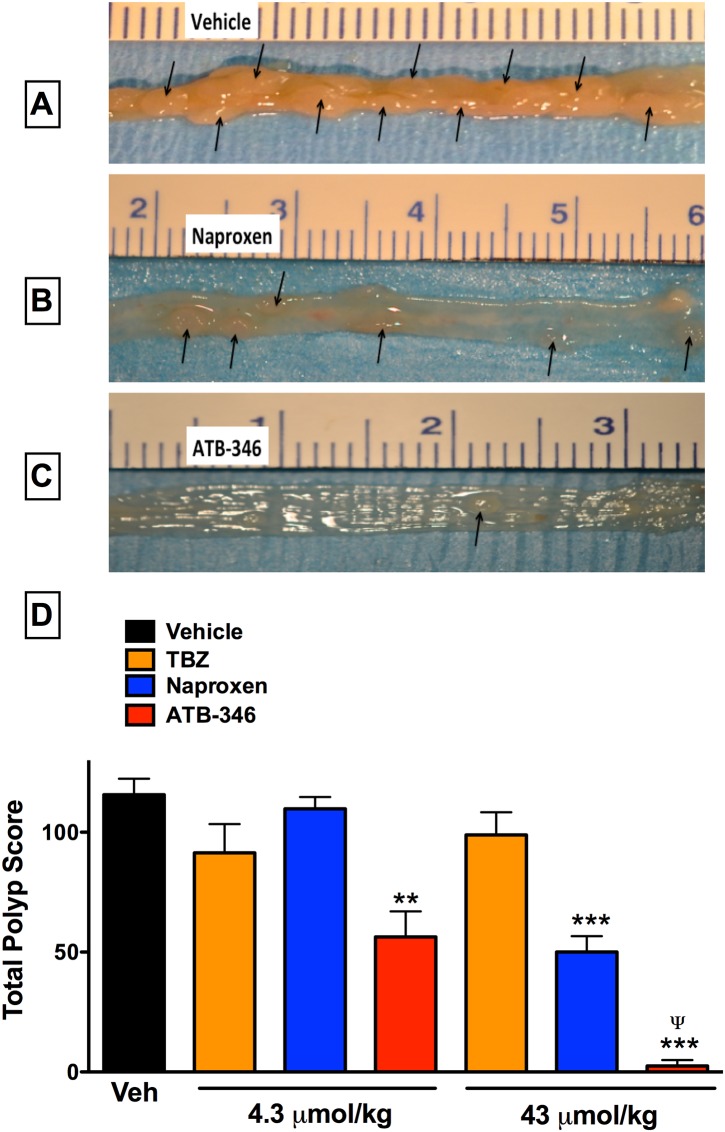
Dose-related preventative effects of oral treatment with ATB-346 or naproxen on intestinal polyp formation in APCMin/+ mice.Groups of at least 6 mice each were treated daily with vehicle, naproxen (1 or 10 mg/kg), or equimolar doses of ATB-346 or of the hydrogen sulfide-releasing moiety of ATB-346 (TBZ; 4-hydroxythiobenzamide). Treatments were started at week 6 of life, and the numbers and areas (in mm2) of polyps in the small intestine and colon were blindly assessed at week 14 of life (panels A, B and C show examples; arrows indicate polyps). Panel D shows the ‘total polyp score’ data (the sum of the areas of all polyps in each mouse). Data are shown as the mean ± SEM. **p<0.01, ***p<0.001 versus the vehicle-treated group (one-way ANOVA and Dunnett’s test). Ψp<0.05 versus the group treated with naproxen at the same dose (Student’s t-test).